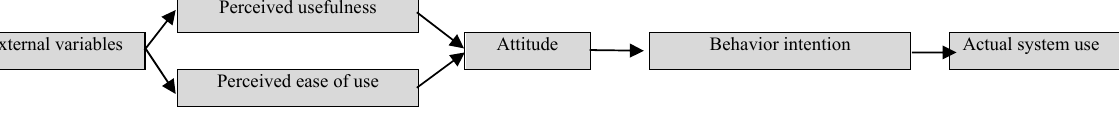
Fig. 1. The Technology Acceptance Model